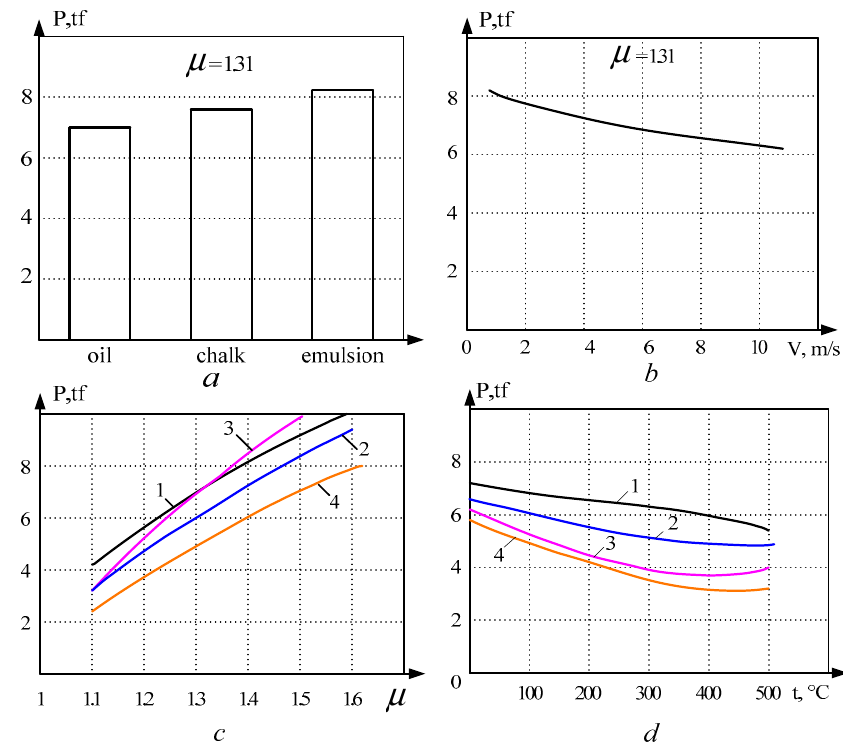
Figure 7. Experimental research at four-roll pass rolling: dependence of rolling pressure on the rolls as a function of the friction coefficient (a), rolling rate (b), drawing down (c), temperature (d); curve 1—steel rolling 70; curve 2—steel R6M5 rolling; curve 3—steel KhI8N9T rolling